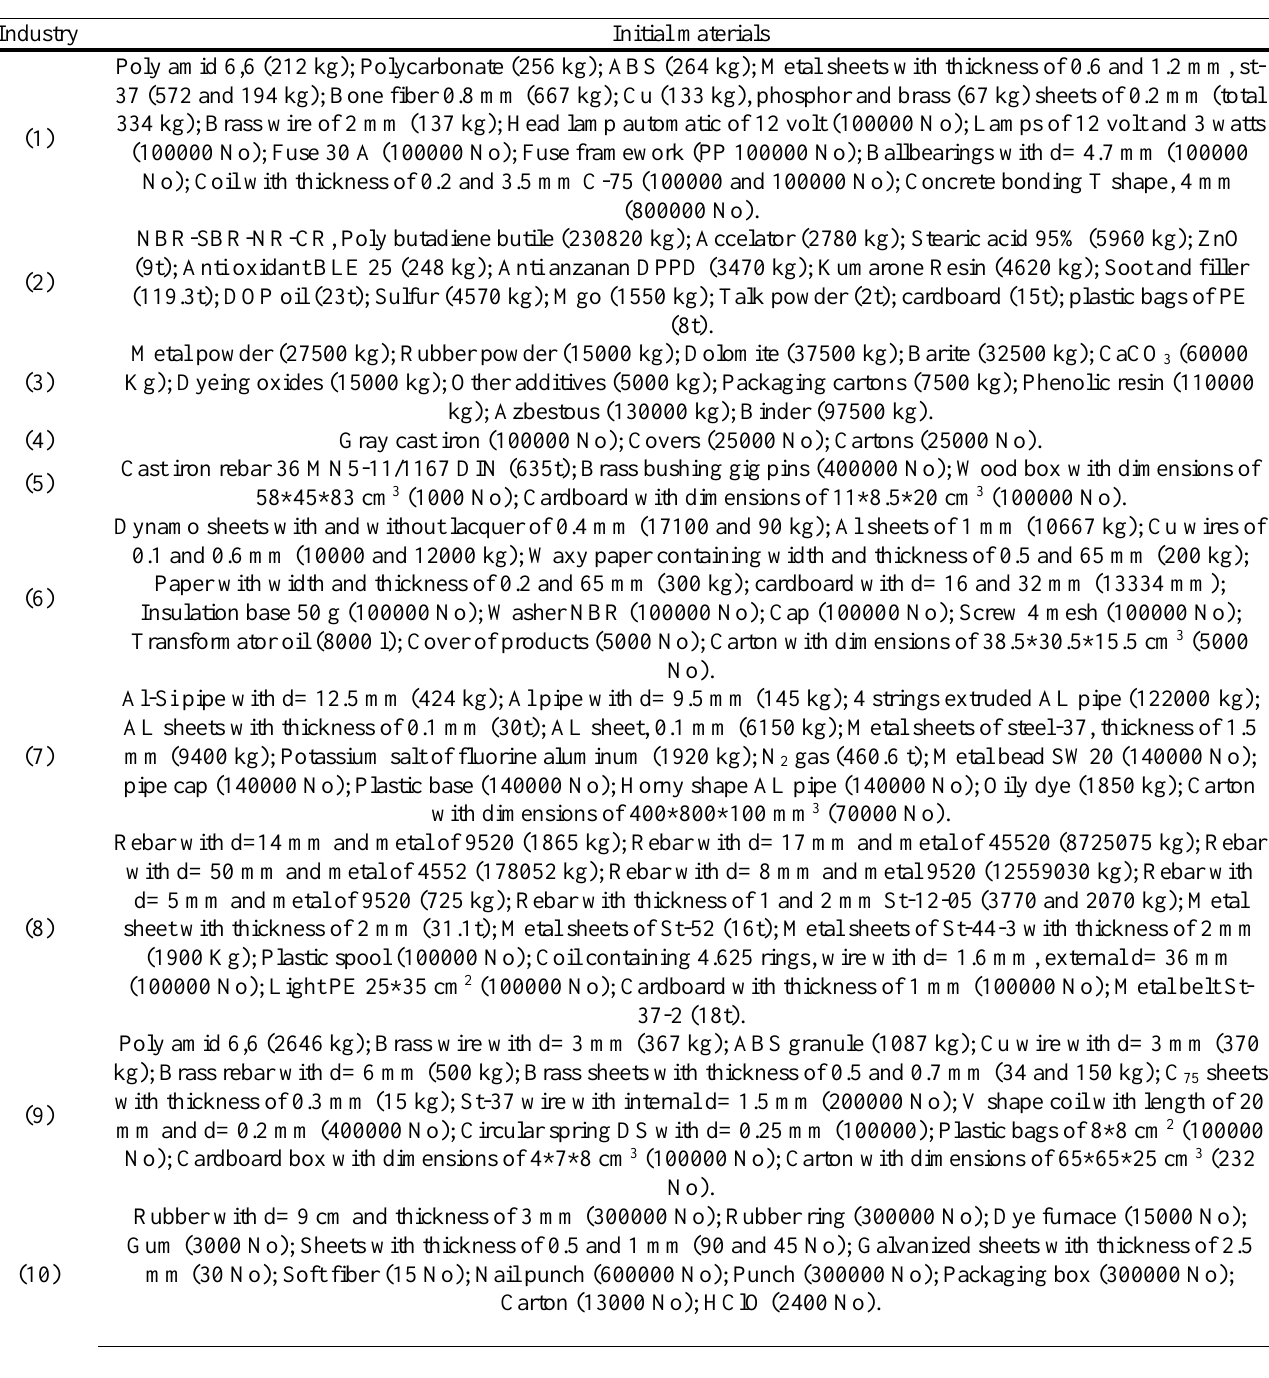
Table 6. Input materials entered into